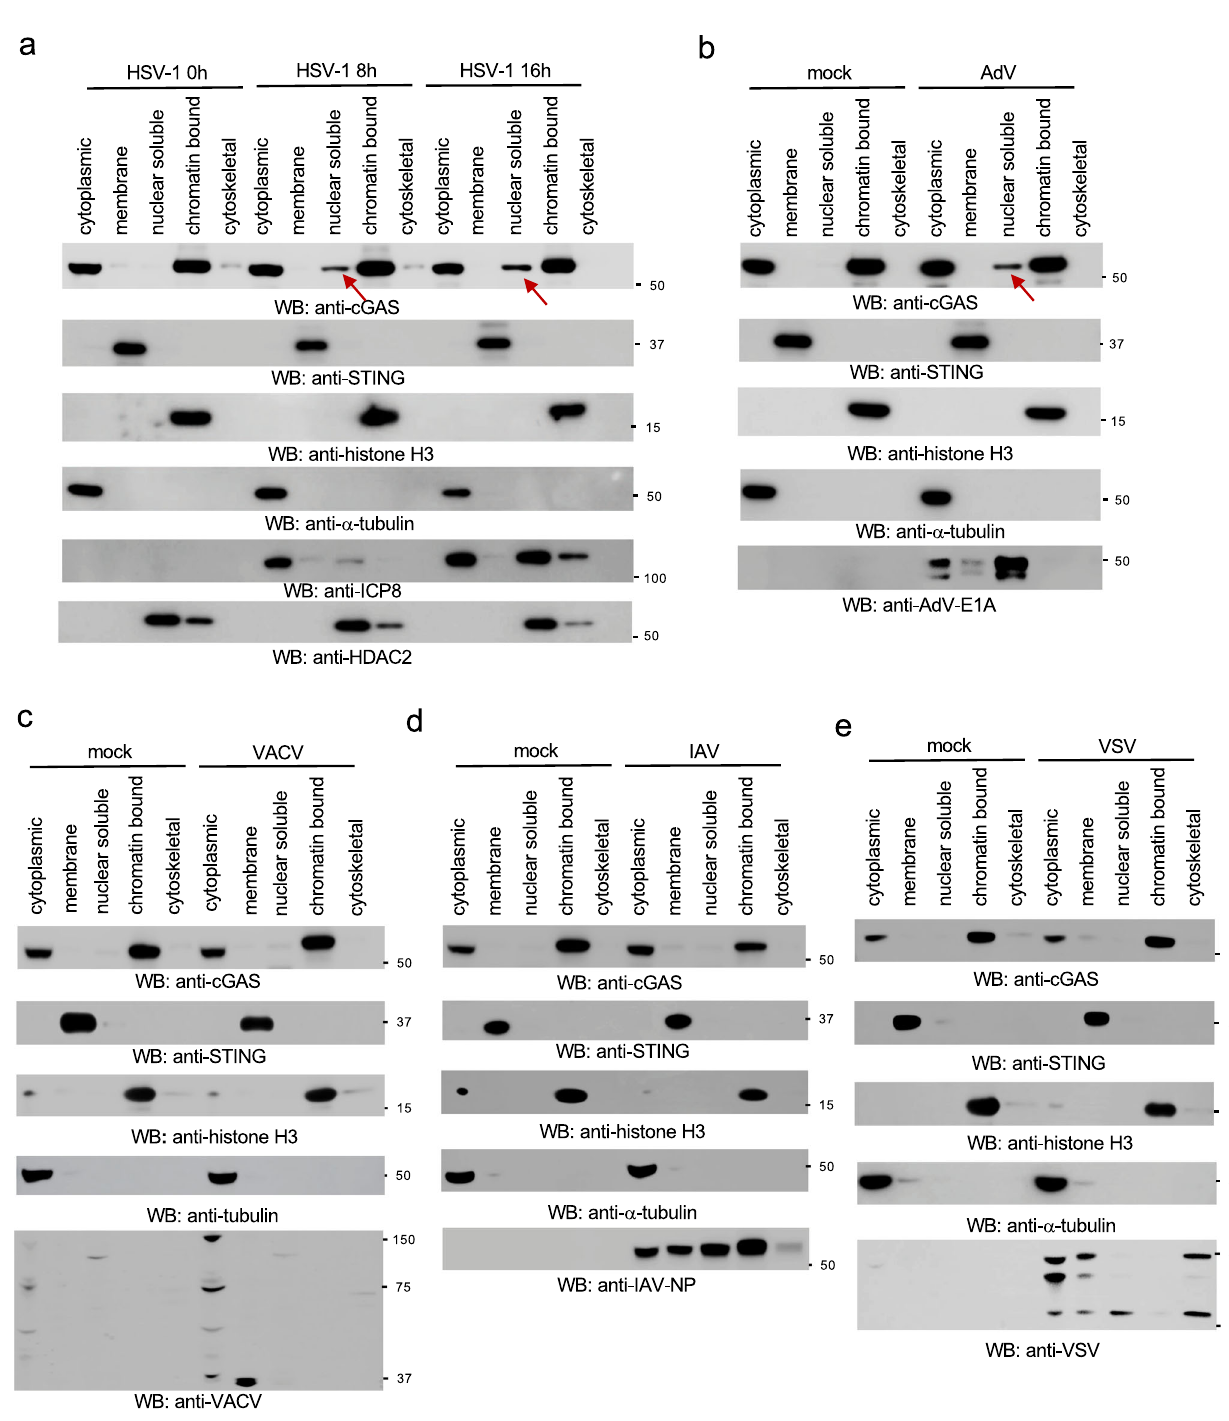
Fig. 2 HSV-1 and AdV cause cGAS release from the chromatin to the nuclear soluble fraction. a RAW 264.7 macrophages were infected with 1 MOI of HSV-1 McKrae for designated times, and then the subcellular fractions of cell lysates were blotted as indicated. The arrow indicates nuclear soluble cGAS after viral infection. STING: membrane marker; α -tubulin: cytosolic marker; H3: nuclear marker; ICP8: HSV-1 viral protein; HDAC2: nuclear marker. b – e RAW 264.7 macrophages were infected with 1 MOI of AdV ( b ), VACV ( c ), IAV ( d ) or VSV ( e ) for 16 h. The subcellular fractions were blotted as indicated. The arrow indicates nuclear soluble cGAS after viral